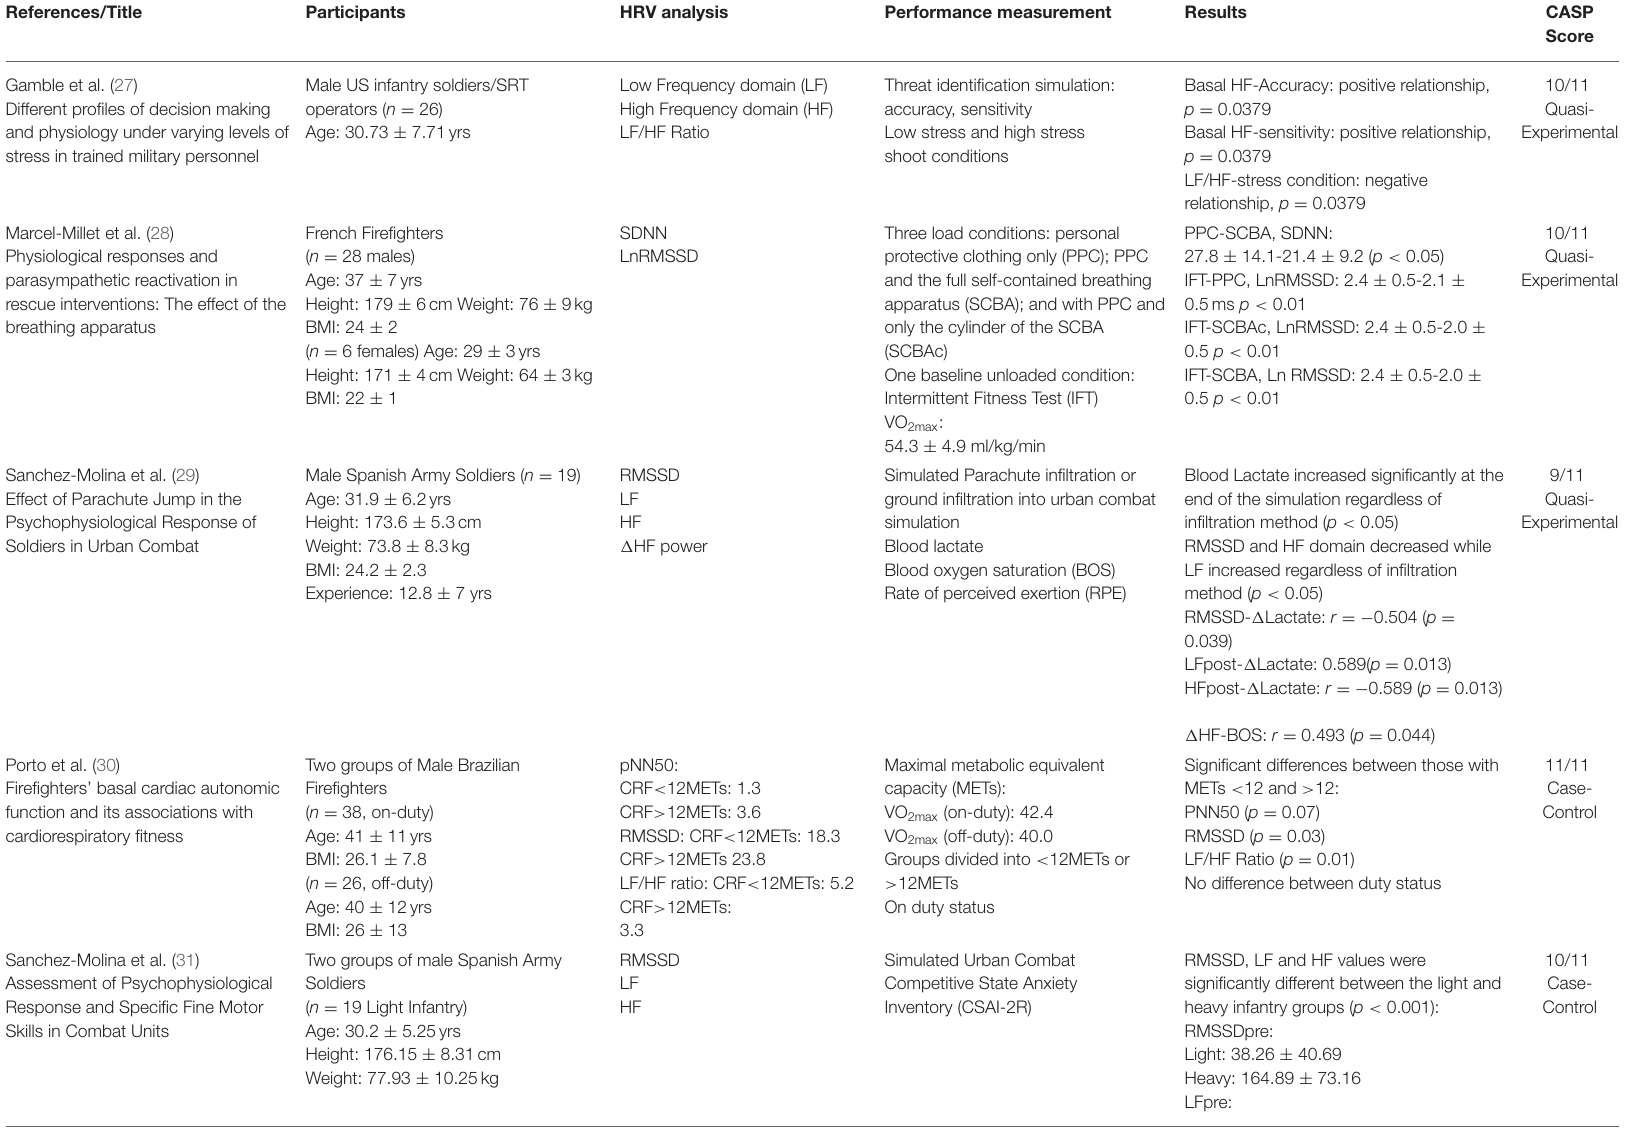
TABLE 2 | Data extraction and summary of selected